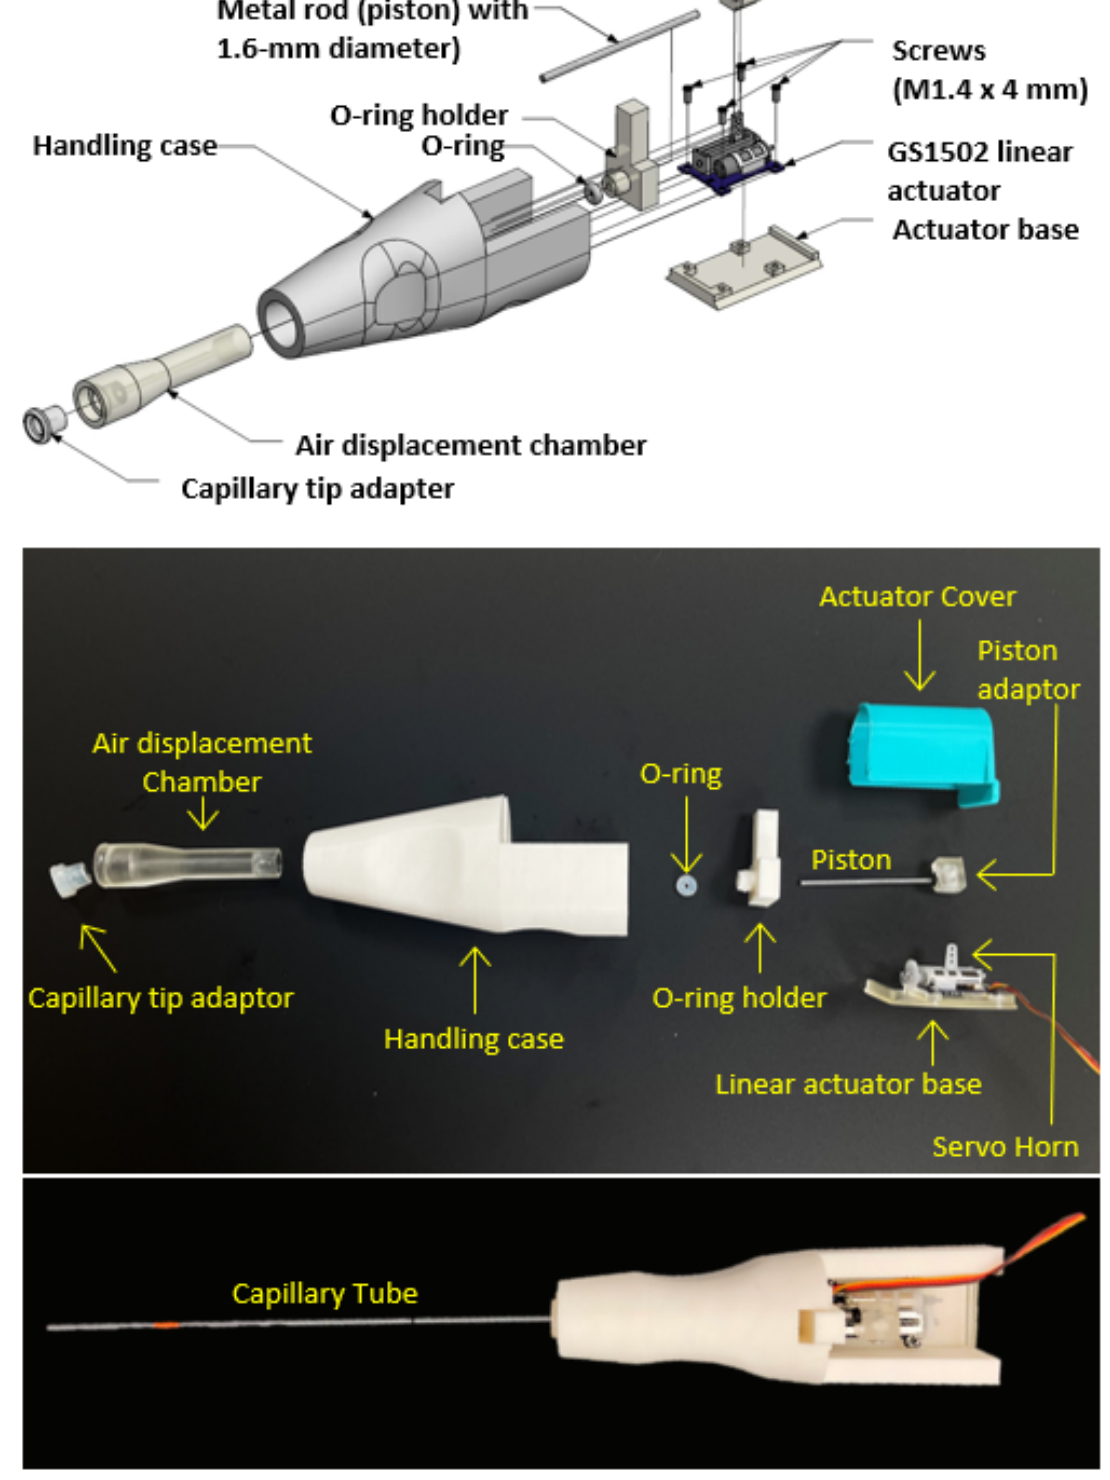
Figure 2. Assembly of the prototype standardized artificial insemination device (SAID). A 3-D rendering ( upper ), fabricated components ( middle ), and an assembled prototype ( lower ) of SAID.